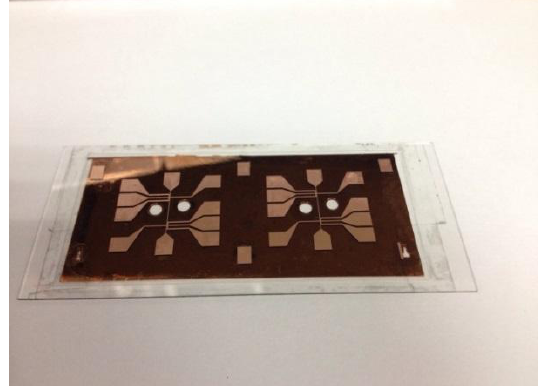
Figure 7. Photograph of a fabricated signal layer transparent atom chip with heat dissipation design on the backside (backside